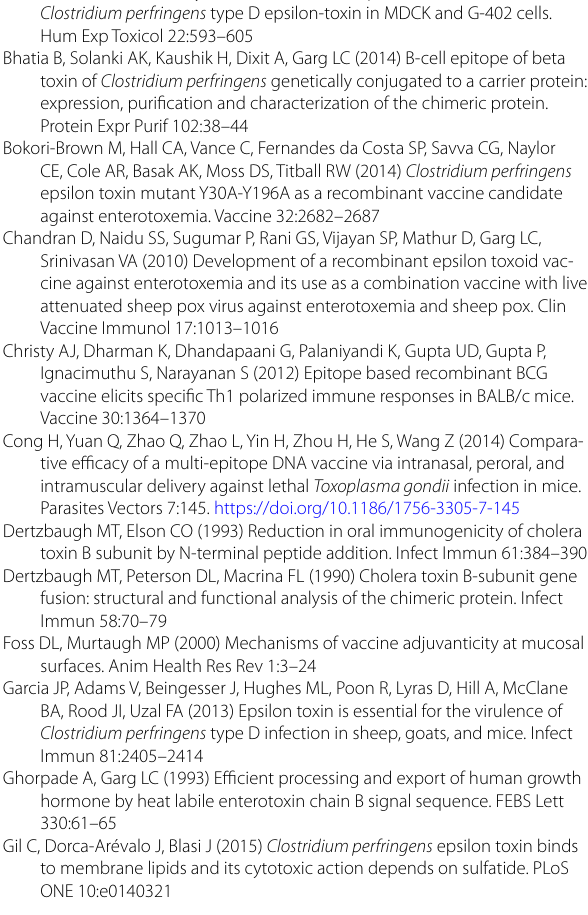
Additional file 1:Fig. S1. Additional Antibody titer determination. Fig. S2 . Microscopic analysis of MDCK cells treated with the rEtx pre-inncubated with anti-rLTB.Etx40-62